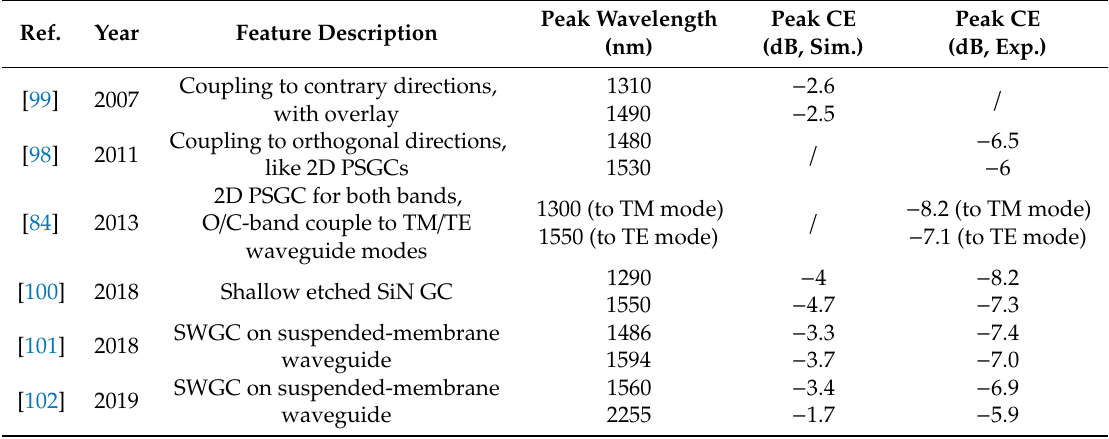
Table 3. Comparison of dual-wavelength-band GCs reviewed in Section 4.2.2. Ref.